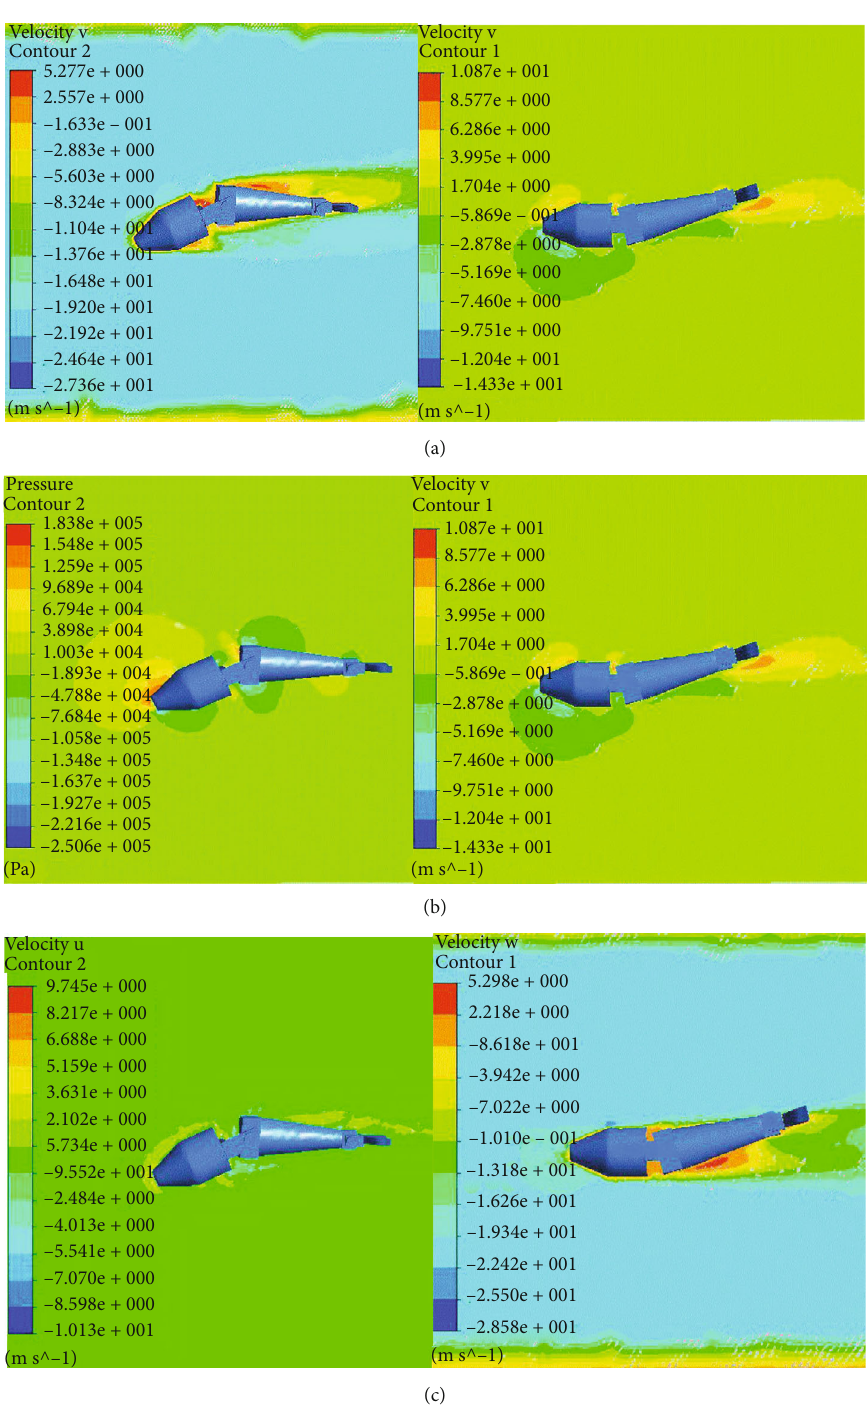
Figure 9: Results with F-S coupling for C-turning. (a) Speed chart for turning left in the X direction. (b) Speed chart for turning right in the X direction. (c) Speed chart for turning left in the Y direction. (d) Speed chart for turning right in the Y direction. (e) Speed chart for turning left in the Z direction. (f) Speed chart for turning right in the Z